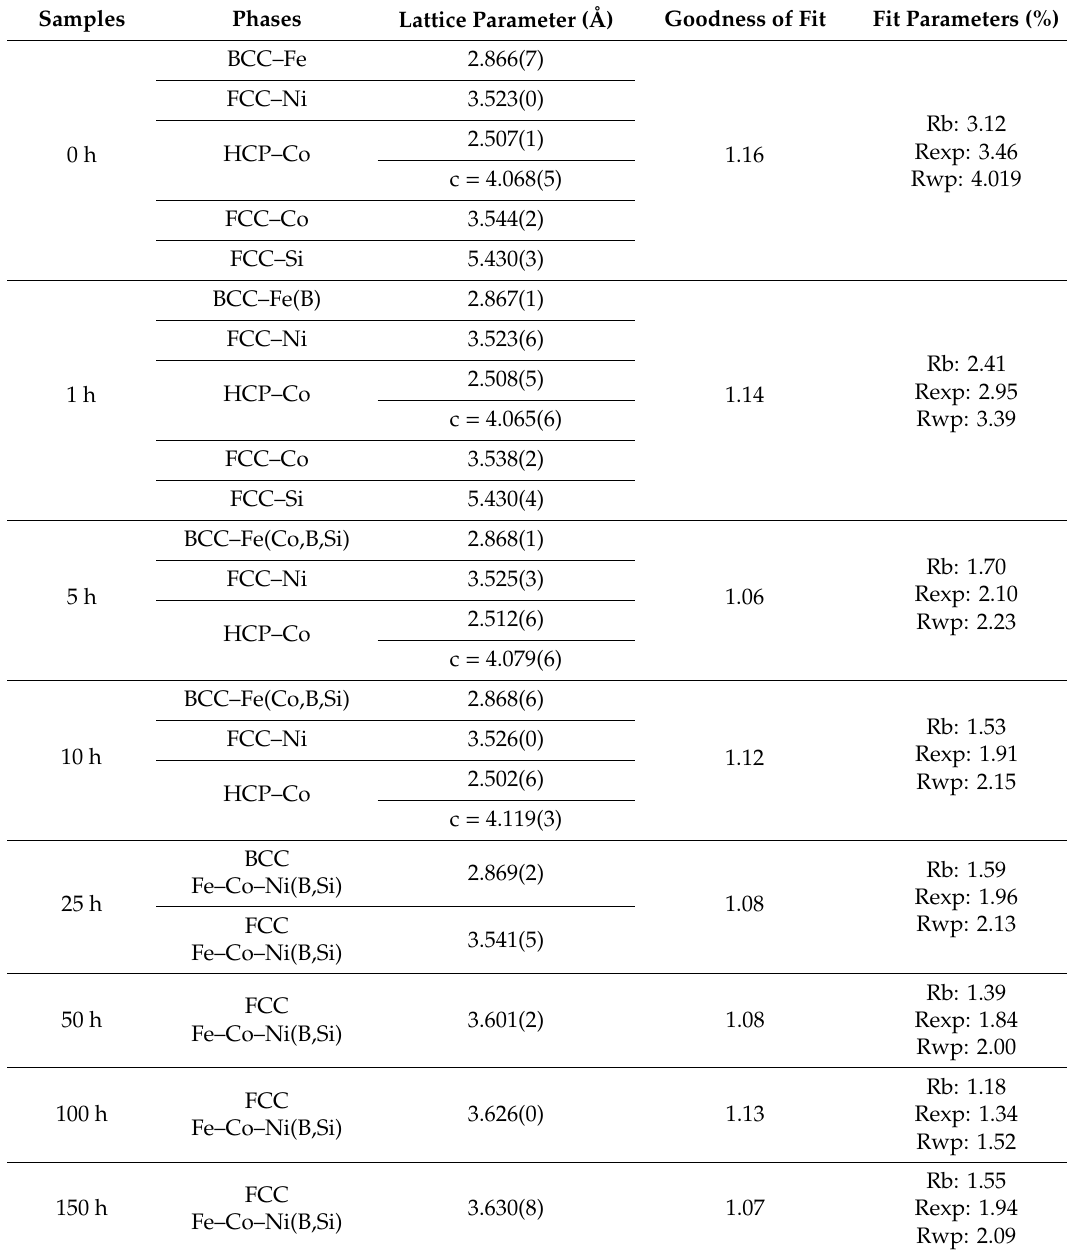
Table 1. Lattice parameter, goodness of fit and fit parameters during